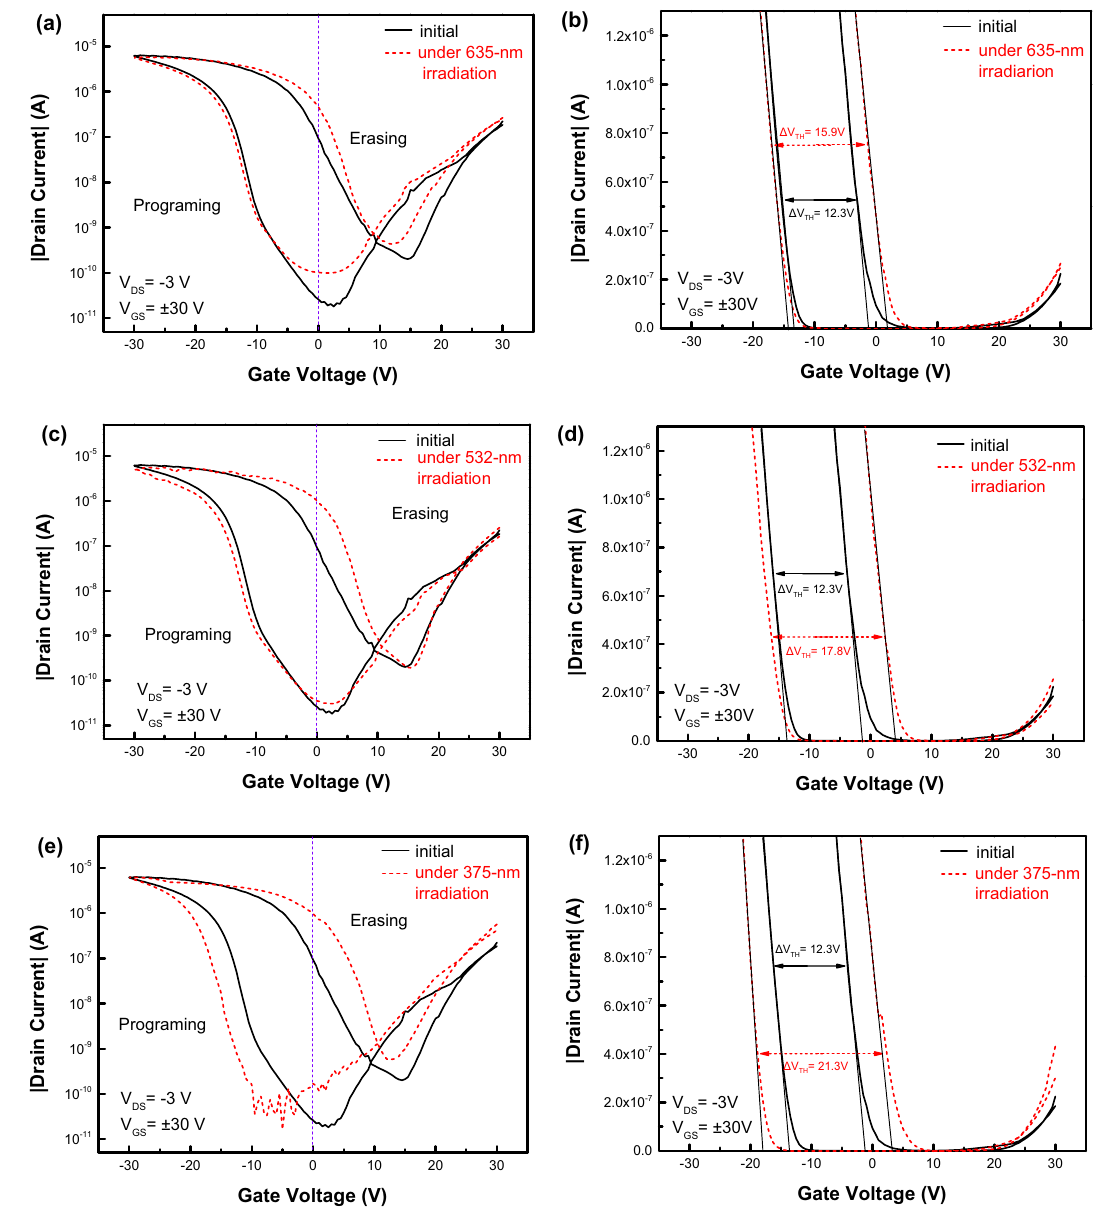
Figure 8. The transfer characteristics of pentacene OFETs without suffering 200-P/E-operation-cycles under the continuous irradiation of 635-nm photons ( a ) in the logarithm form ( b ) in the linear form, under the continuous irradiation of 532-nm photons ( c ) in the logarithm form ( d ) in the linear form, and under the continuous irradiation of 375-nm photons ( c ) in the logarithm form ( d ) in the linear ration technique with a shadow mask, and the deposition rate of pentacene was kept at 0.1–0.3 Å/s. Cu source/ drain electrodes (about 80 nm) were deposited on pentacene film by using thermal-evaporation technique with another shadow mask at a deposition rate of ≈ 0.5 Å/s. Device characterization. The thicknesses of PVN (10 nm) and ZnO films (5 nm, 10 nm,15 nm, 20 nm 25 nm, and 30 nm) were measured with a spectral ellipsometer (J.A. Woollam, RC2). The thicknesses of penta- cene film and Cu film were measured using a quartz crystal microbalance. The surface morphologies of ZnO, PVN, and pentacene were investigated by atomic force microscopy (AFM) (Asylum Research, Cypher-ES). The crystal structures of ZnO film and pentacene film were characterized by X-ray diffraction (XRD) (Rigaku, Ultima III X). The analyses of element valence states of ZnO films were carried out by X-ray photoelectron spectroscopy (XPS, Thermo Scientific, K-Alpha) under high vacuum conditions (3 × 10 –6 Pa). The electrical characterization of pentacene OFET devices were performed by using a Keithley 4200 semiconductor parameter analyzer on a Cascade Summit 11000B-M platform in air.